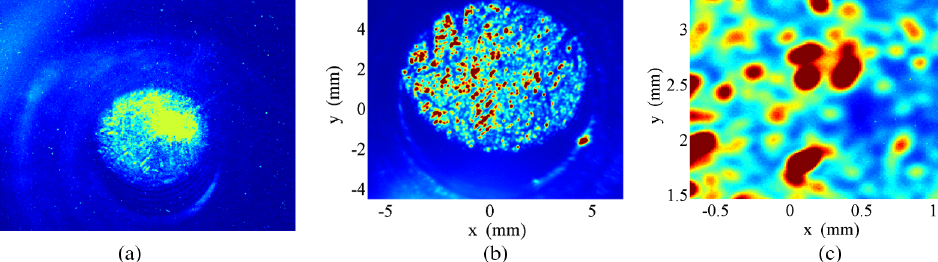
FIG. 10. Cathode surface images taken through the extraction mirror (opposite to the injection mirror) using a camera just outside of the vacuum chamber. (a) This image was taken using visible light after the gun was rf conditioned but before the first photoelectron beam was generated. The surface already appears damaged at this stage. (b) Cathode surface imaged with visible light after 2 years of operation of the gun. The center circle of bright spots fills the entire 7 mm diameter cathode. (c) Zoomed area of the cathode image shown in (b).